Question: Which visualization type does this figure use?
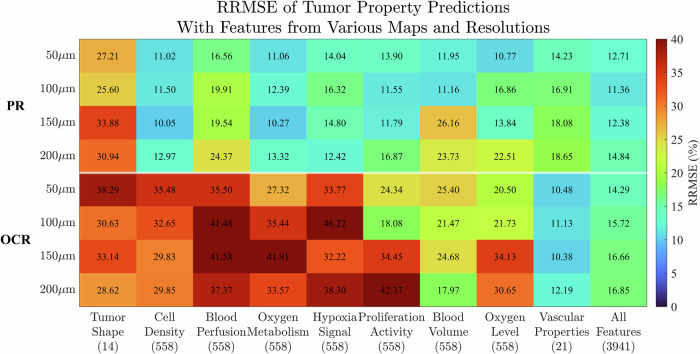
Answer: heatmap